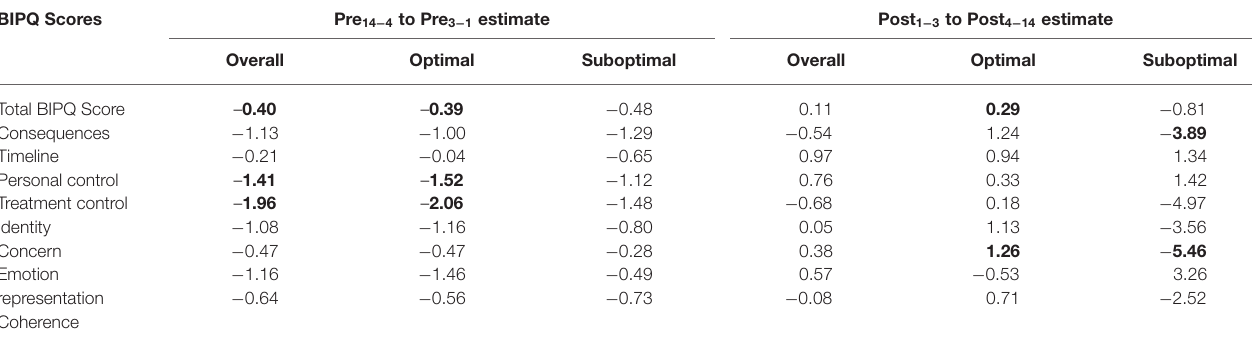
TABLE 3 | Coefficients for the relationship between BIPQ scores and whitecoat adherence. BIPQ